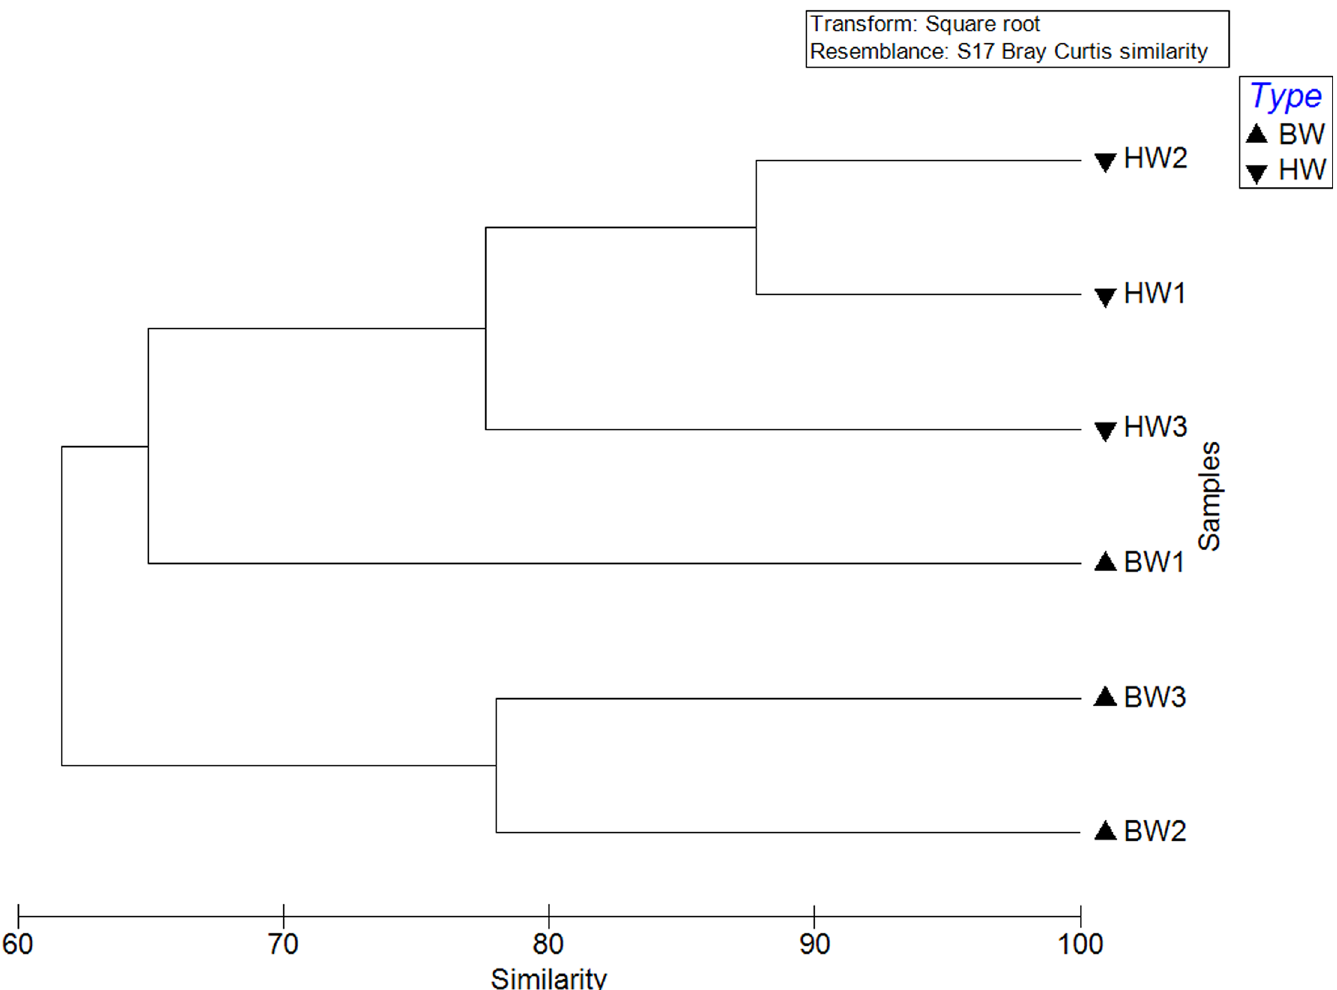
Fig 6. Clustering analysis of microbial composition in ballast and harbor waters based on Bray-Curtis similarity index.